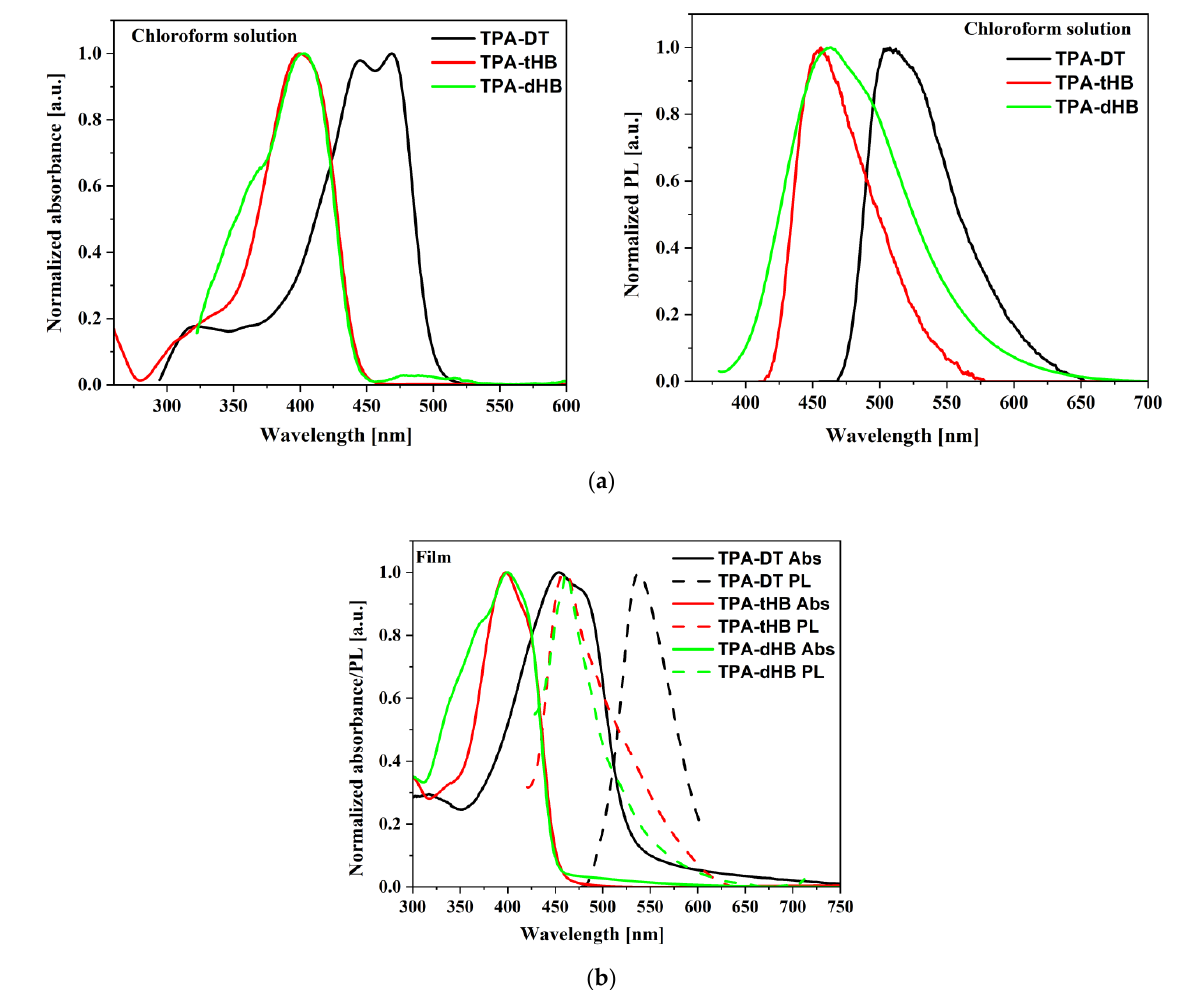
Figure 3. UV – vis and PL spectra of azomethines in chloroform ( a ), and in film ( b ). Figure 3. UV–vis and PL spectra of azomethines in chloroform ( a ), and in film ( b